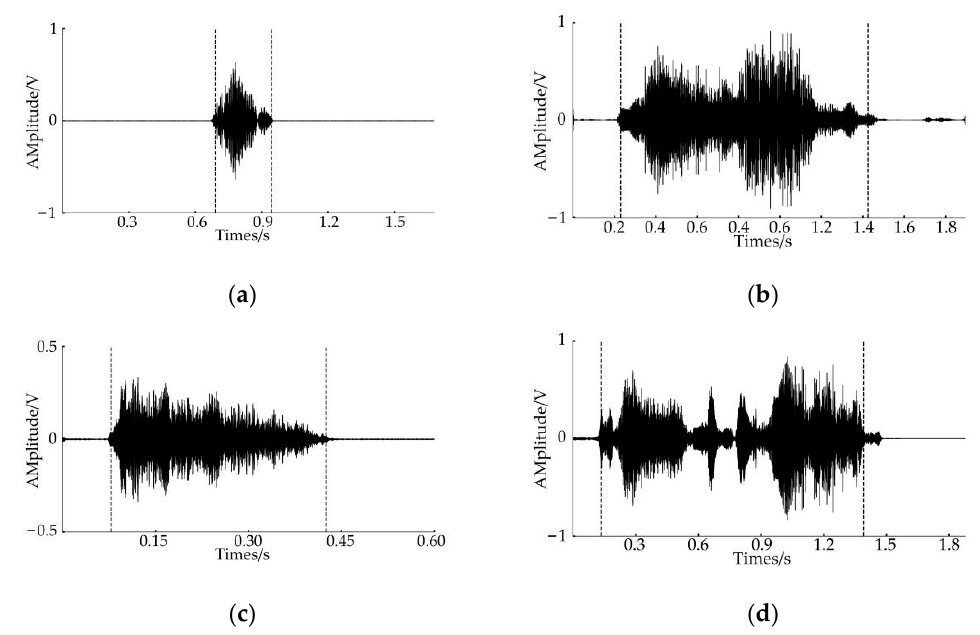
Figure 4. Endpoint detection results of pig sound signals: ( a ) pig cough sound endpoint detection results; ( b ) non-pig cough sound 1 endpoint detection results; ( c ) non-pig cough sound 2 endpoint detection results; ( d ) non-pig cough sound 3 endpoint detection results.